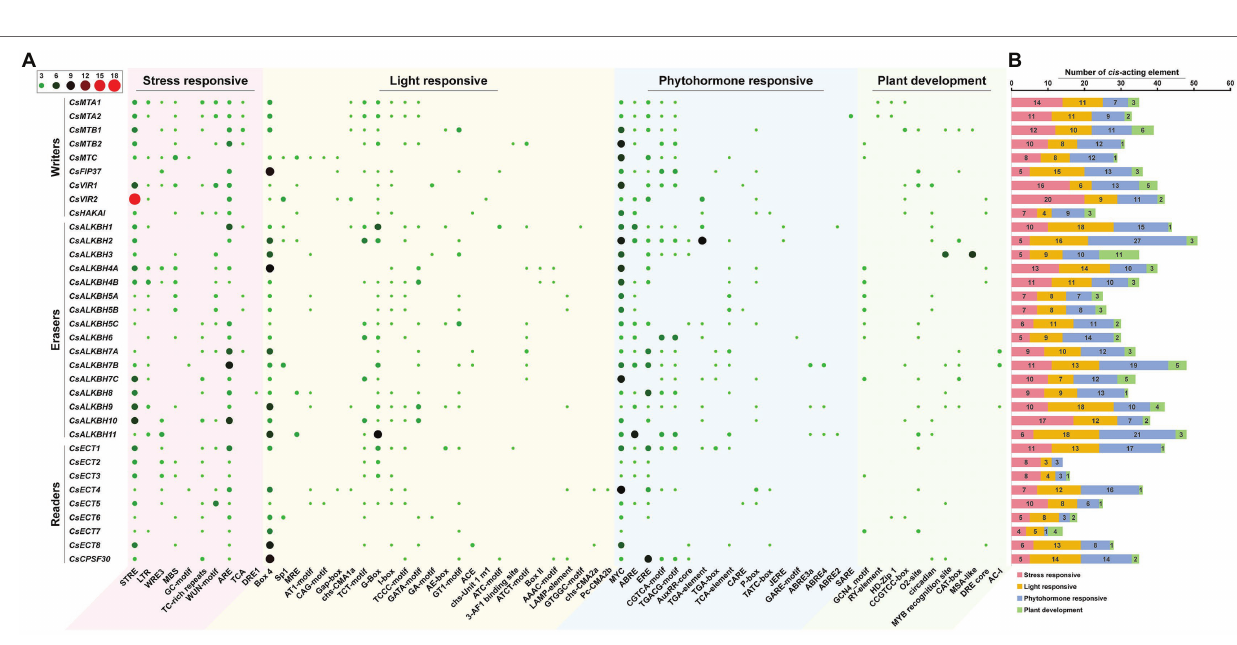
FIGURE 7 | Analysis of cis -acting elements in the promoter regions of m6A regulatory genes in tea plants. (A) The distribution of cis -acting elements in the promoter regions of m6A regulatory genes. (B) The histogram of cis -acting elements in each